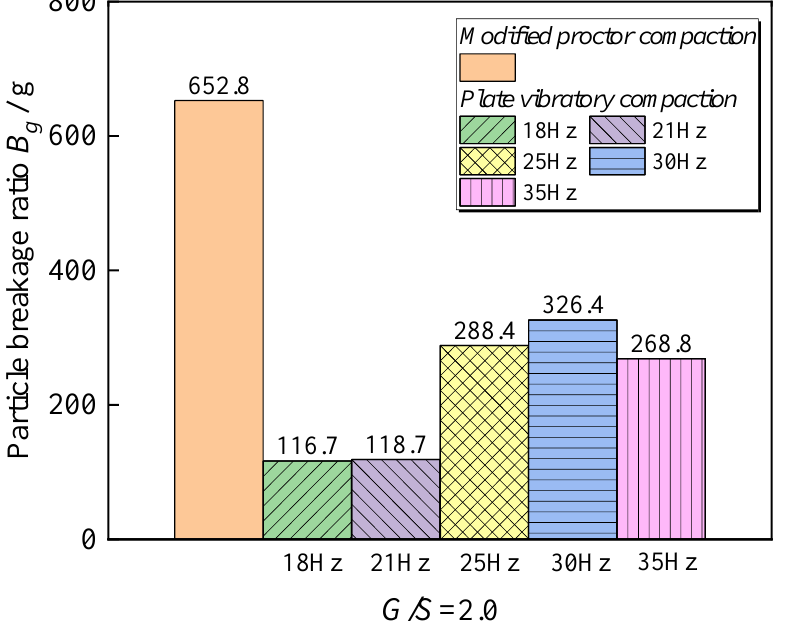
Figure 13. Particle breakage Bg values for UPAB specimens with a G / S value of 2.5 under different combinations of vibratory parameters.